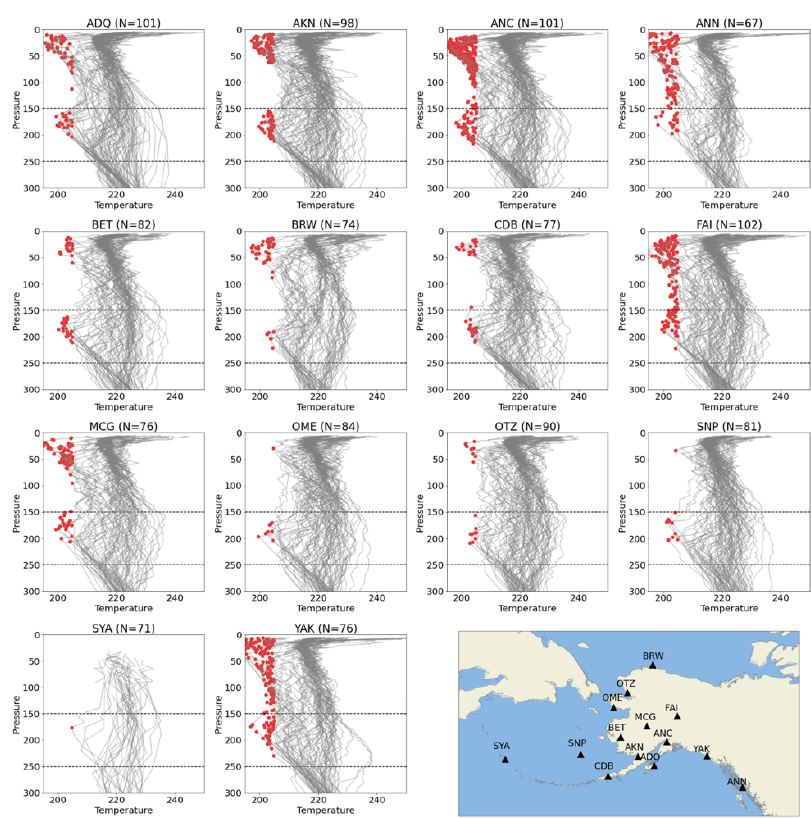
Figure 2. Radiosonde temperature profiles from 14 Alaskan sites for February through March 2018. A total of 1180 profiles are shown. Radiosondes are released twice daily at 00 UTC and 12 UTC. Red points indicate where CAA is detected. The vertical layer between the two dashed lines in each plot shows the typical transpolar flight cruising altitudes, assuming a standard atmosphere.